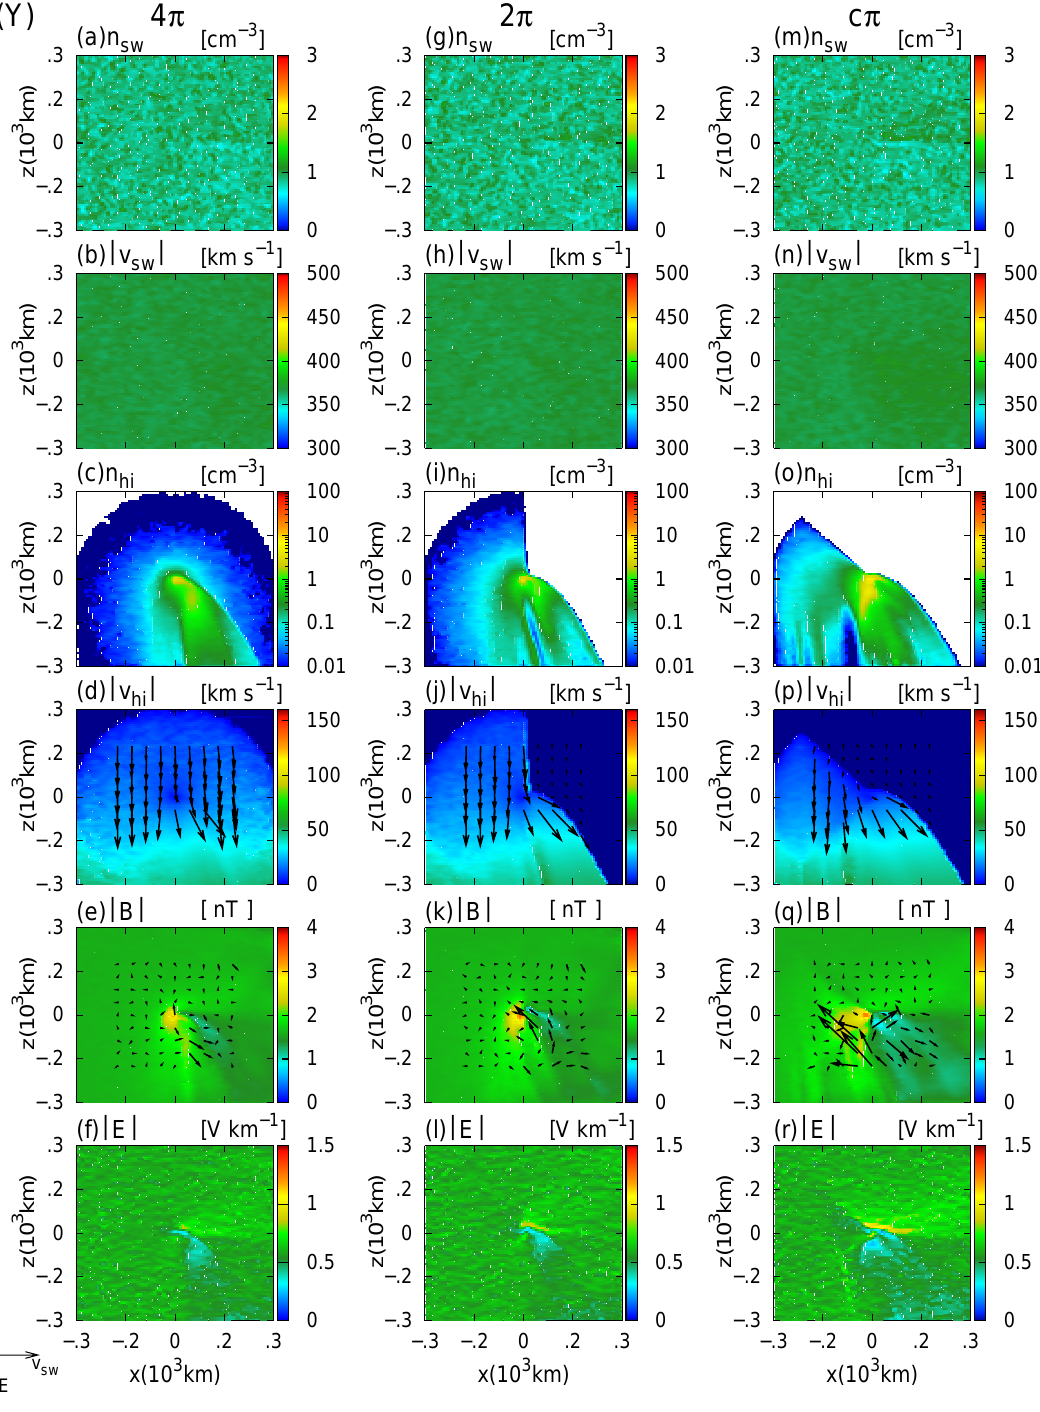
Fig. 9. Cut through the polar plane of the simulation box at 3.25AU. From left to right we show the results for the spherically symmetric, for the day side restricted and the cone shaped model. The solar wind density ( a, g, m ) and bulk velocity ( b, h, n ), the cometary ion density ( c, i, o ) and bulk velocity ( d, j, p ), the magnetic ( e, k, q ) and the electric field ( f, l, r ) are shown. The undisturbed solar wind flow points in +x while the convective electric field points in -z direction. The solar wind flow remains uneffected by the cometary plasma. Spatial confinement only increases the pileup of the magnetic field (e, k) and in case of (q) it leads furthermore to a detachment of the magnetic field from the nucleus surface. With increasing spatial confinement the pileup of the magnetic field leads to an increasing twist of the cometary ion tail in direction of the solar wind